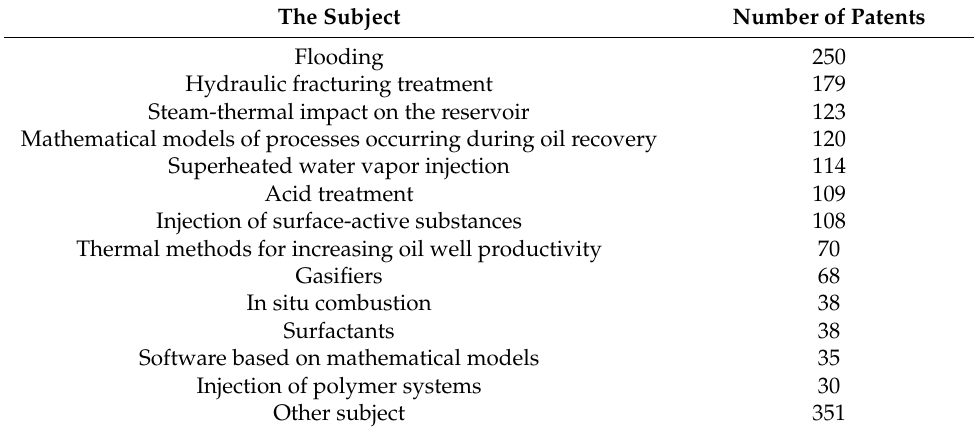
Table 1. Technological clustering in the field of enhanced oil recovery in 2010–2020 for the area of intensive patenting.